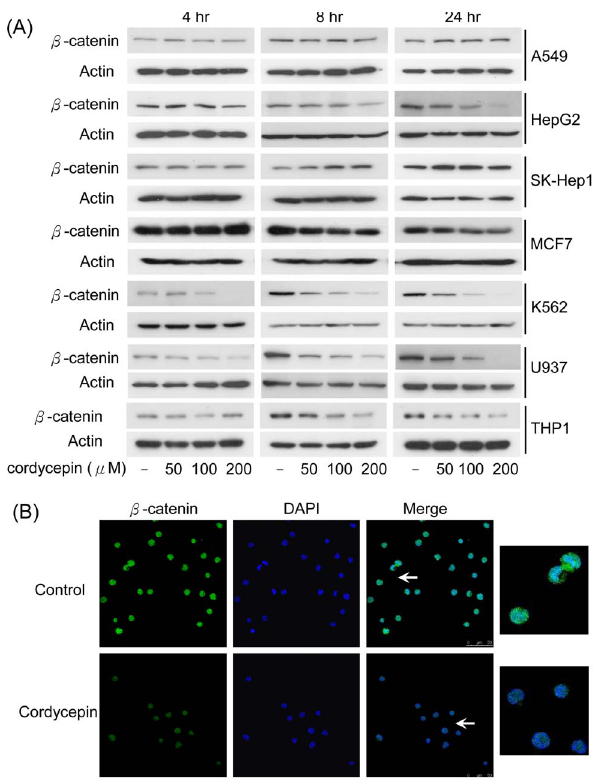
Figure 2. Effect of cordycepin on b -catenin expression. (A) A549, HepG2, SK-Hep1, MCF7, K562, U937 and THP1 cells were treated with different concentrations of cordycepin for 4 to 24 hrs. b -catenin protein levels were determined by Western blot analysis. Actin was used as a loading control. (B) Expression level and subcellular localization of b - catenin was examined by immunofluorescent confocal microscopy. The right panels are magnified images for the indicated area of arrows.